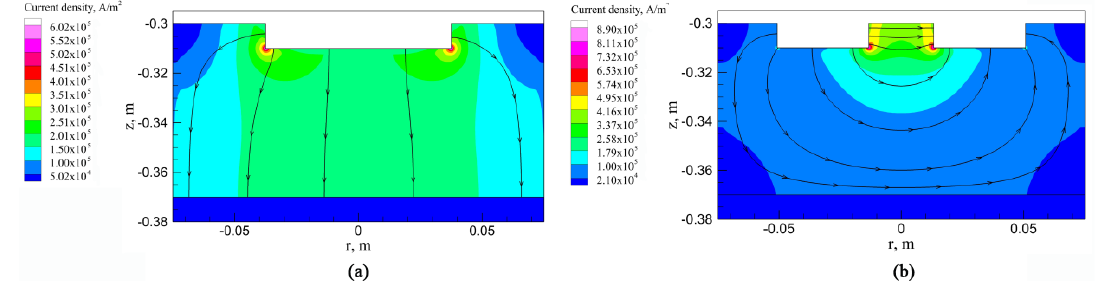
Figure 5. Current density distribution in slag pool. ( a ) OE-ESR. ( b ) TSCE-ESR. The black line represents the current flow line.